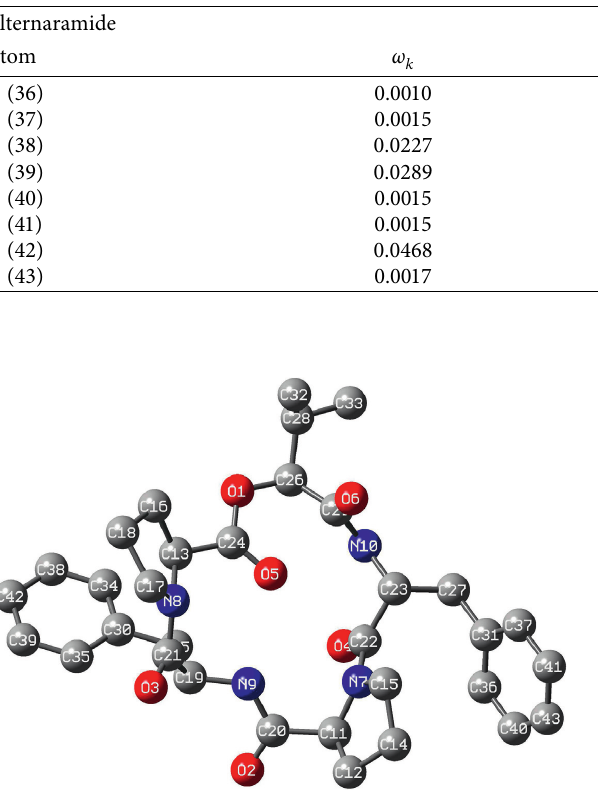
Figure 5: Molecular structure of alternaramide showing the la- belling over the atoms. H atoms are not shown.